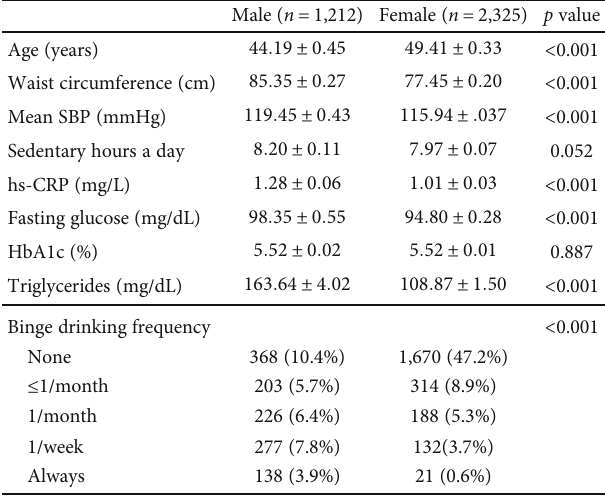
Figure 1: Flow chart on inclusion process of study population. Table 1: Baseline characteristics for